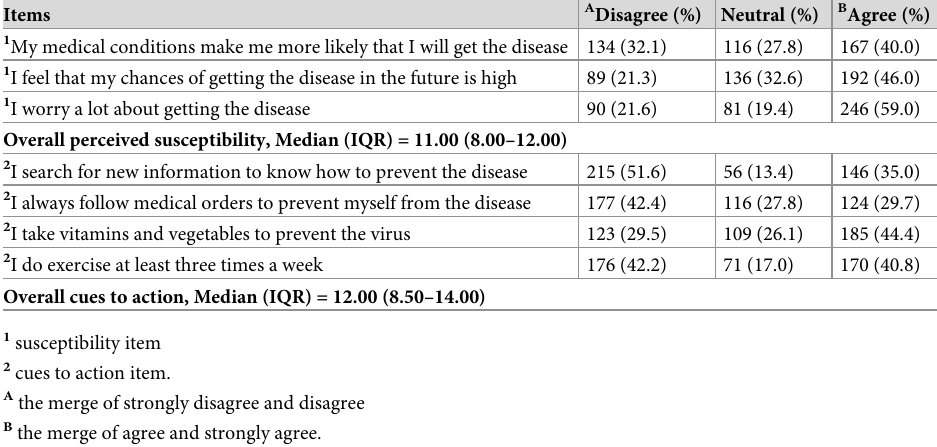
Table 3. The study participants’ perceived susceptibility and cues to action.